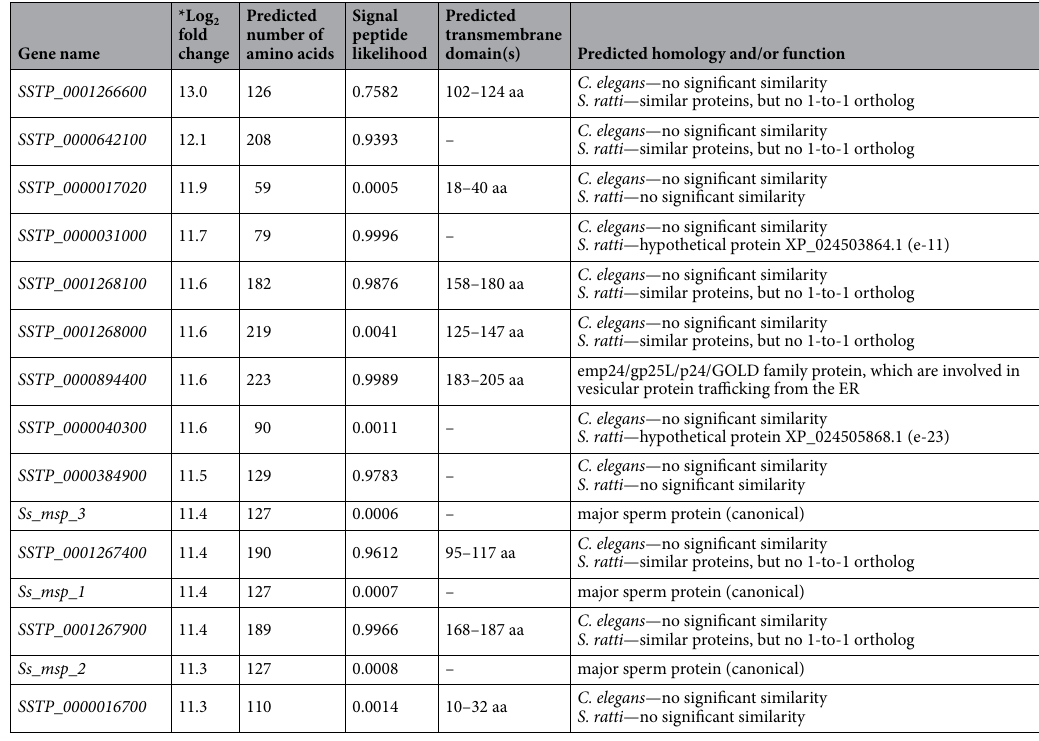
Table 1. Most up-regulated transcripts in S. stercoralis free-living adult males in comparison to free-living adult females. *For significance: FDR < 0.05, log 2 fold change > 1.0, and log 2 CPM > 1.0 in ≥ 1 developmental